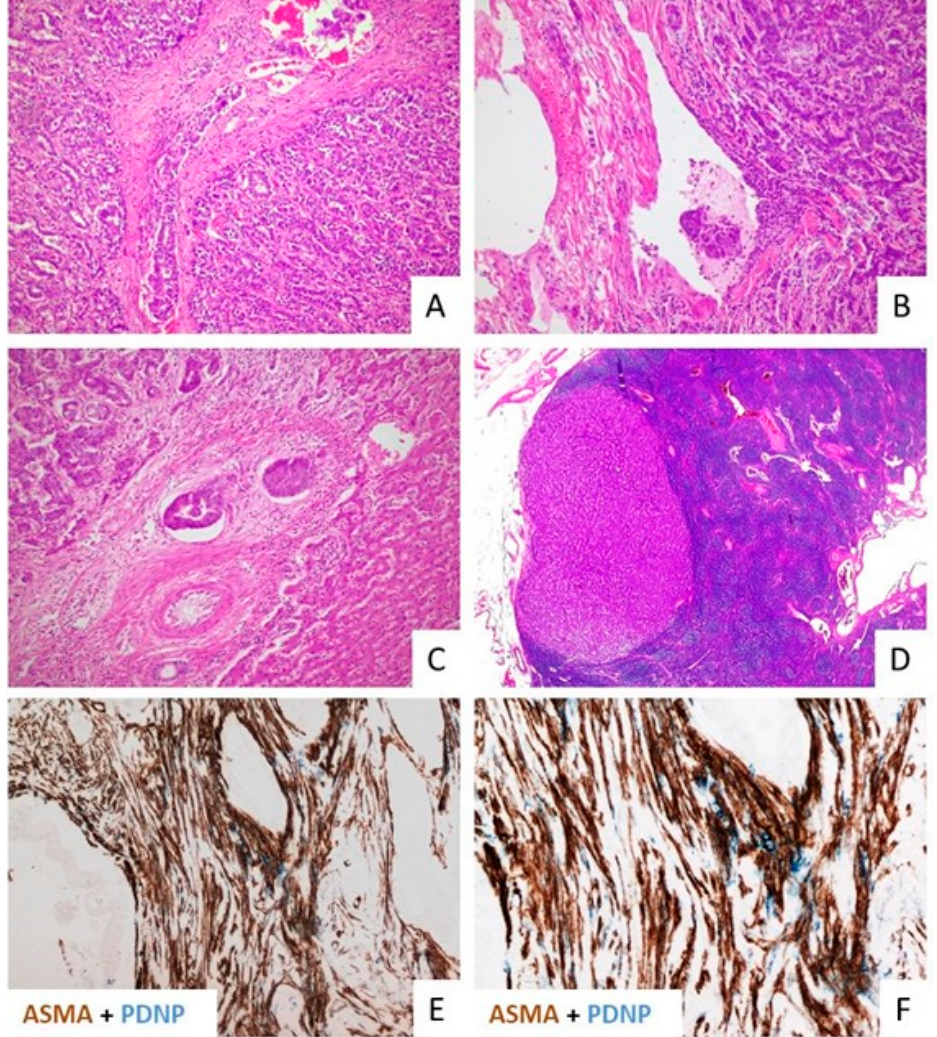
Figure 1. Histological evidence of lymphoinvasion with lymph node metastasis and spatial configuration of the lymphatic vascularization within the tumor microenvironment. ( A – D ). H&E showing examples of intra-tumoral ( A ) and peri-tumoral lymphatic vessel invasion in iCCA ( B ); lymphatic invasion can also be observed in portal tracts of adjacent non-tumoral liver ( C ). Neoplastic lympho-invasion in iCCA eventually leads to lymph node metastases ( D – F ). Dual immunohistochemistry for Podoplanin (PDPN) (blue) and α -SMA (brown) shows the close alignment of PDPN + lymphatic endothelial cells with α -SMA + cancer-associated fibroblasts in the same area taken at different magnifications, to highlight the intense functional link between the two stromal cell types. Original magnifications: ( A – C , E ): 10×; ( D ): 1.25×; ( F ): 20×.